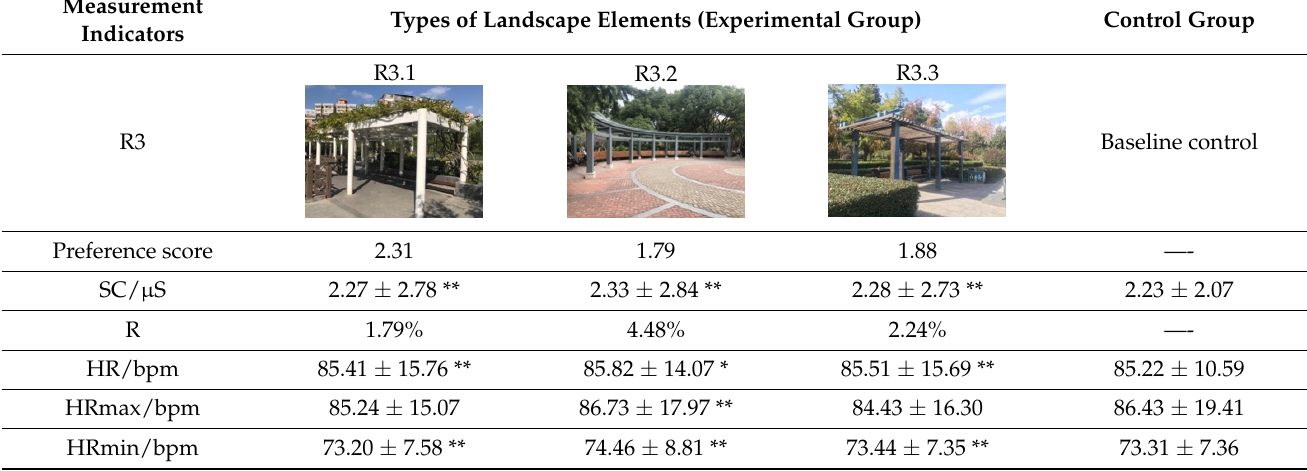
Table 16. Physiological indicators of participants before and after measurement in response to different green corridor spaces.